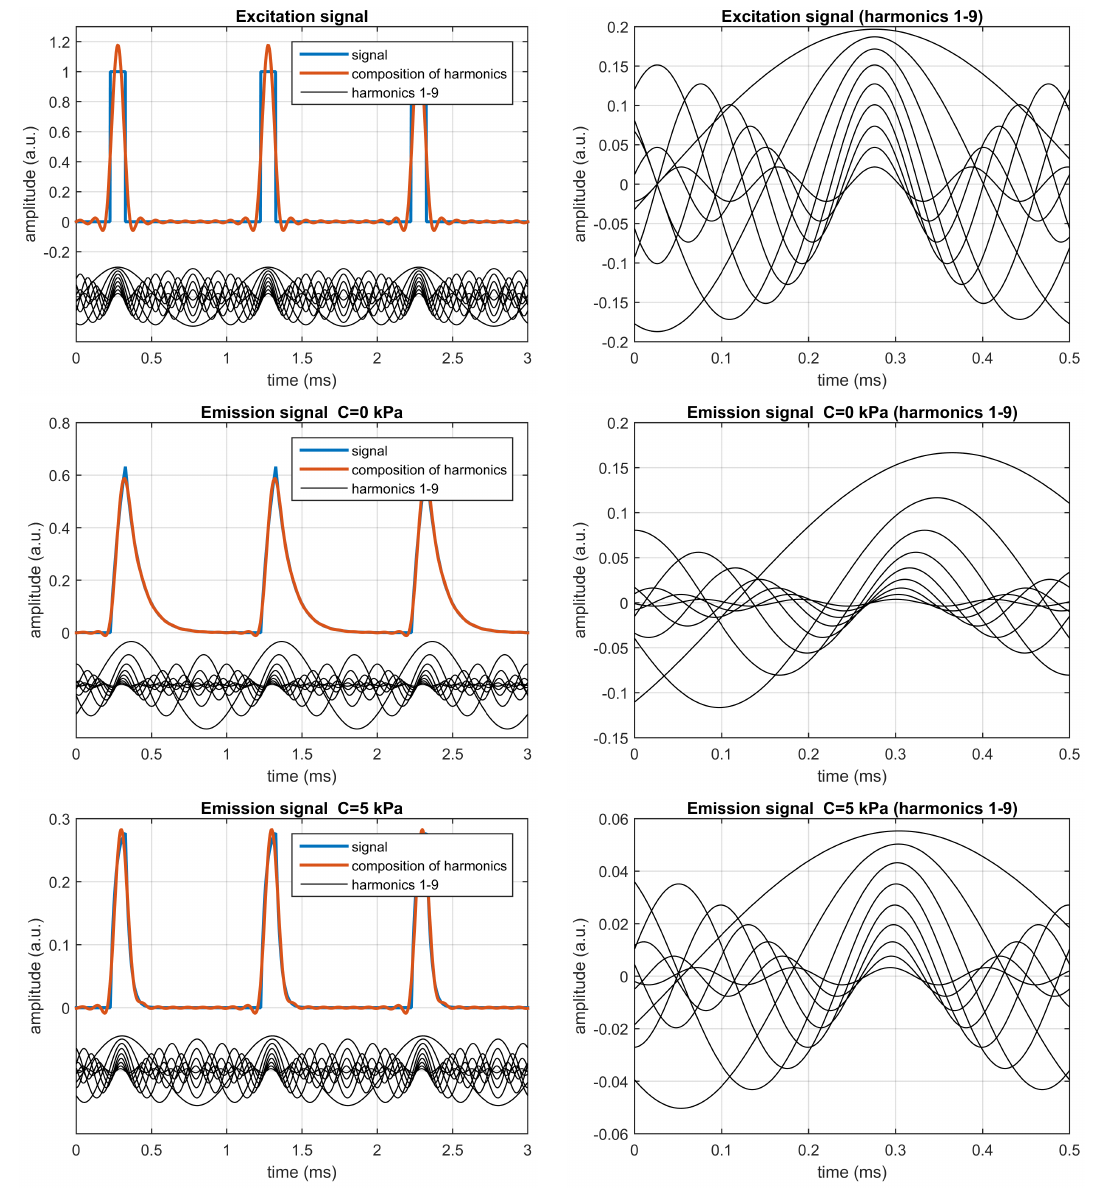
Figure 2. Analysis of the excitation signal ( top ) and the emission signals at C = 0 kPa ( center ) and at C = 5 kPa ( bottom ). The left panels represent the excitation or emission signals, the harmonics (from 1st to 9th), and the composition of the harmonics. The right panels show a detail of the harmonics for each signal. These plots correspond to the simulated monoexponential luminescent system with M 0 = 1, τ 0 = 100 µ s, and k = 0.5 (kPa) − 1 , excited with rectangular pulses of amplitude 1.0 a.u. presented at 1 kHz with 10% duty